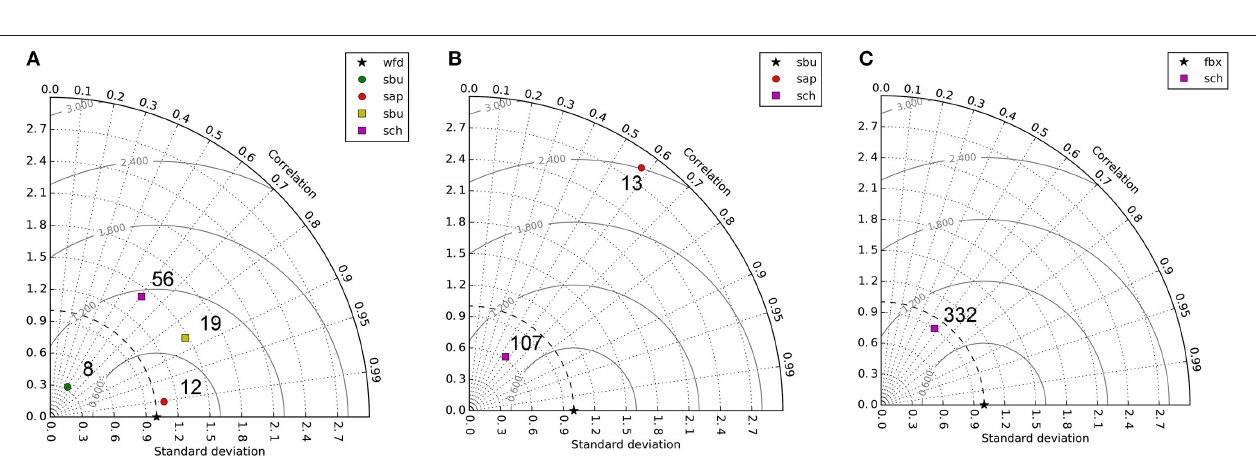
FIGURE 5 | Taylor diagrams showing the statistics of the cross validation between the different datasets. (A) Statistics for the cross validation of wfd with sbu and sap for winter DIN (circles) and of wfd with sbu and sch for chlorophyll (squares). (B) The same for sbu with sap for winter DIN (circle), and sbu with sch for chlorophyll (square). (C) Cross validation of fbx with sch . The number adjacent to each point represents the number of matching points for each cross validation.